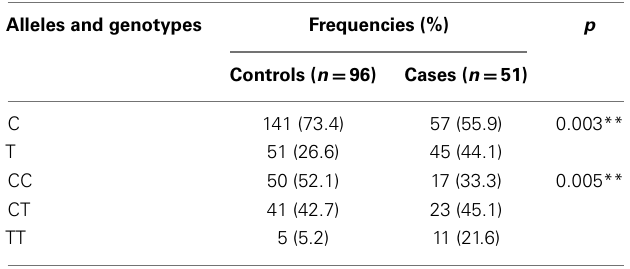
Table 4 |Association analysis of clinical subclasses with IL10 c.-819T SNP in patients with Behçet’s